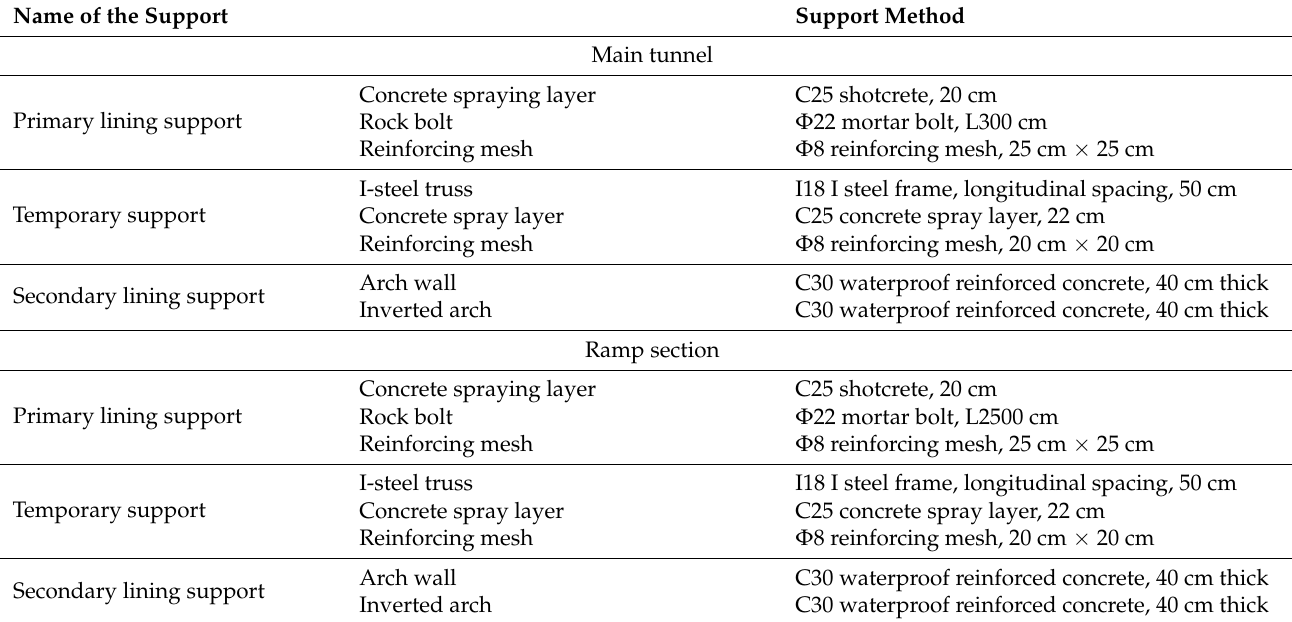
Table 1. Parameters of the retaining